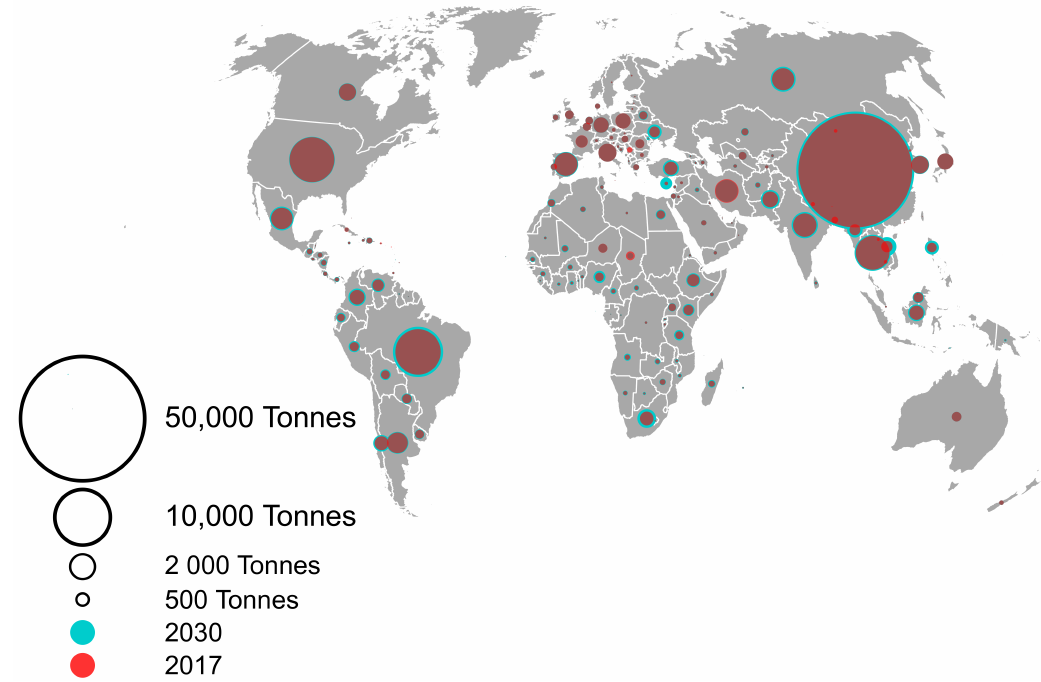
Figure 1. Antimicrobial consumption per country in 2017 and 2030. The size of the circles corresponds to the amounts of antimicrobials used. Dark red circles correspond to the amounts used in 2017, and the outer blue ring corresponds to the projected increase in consumption in